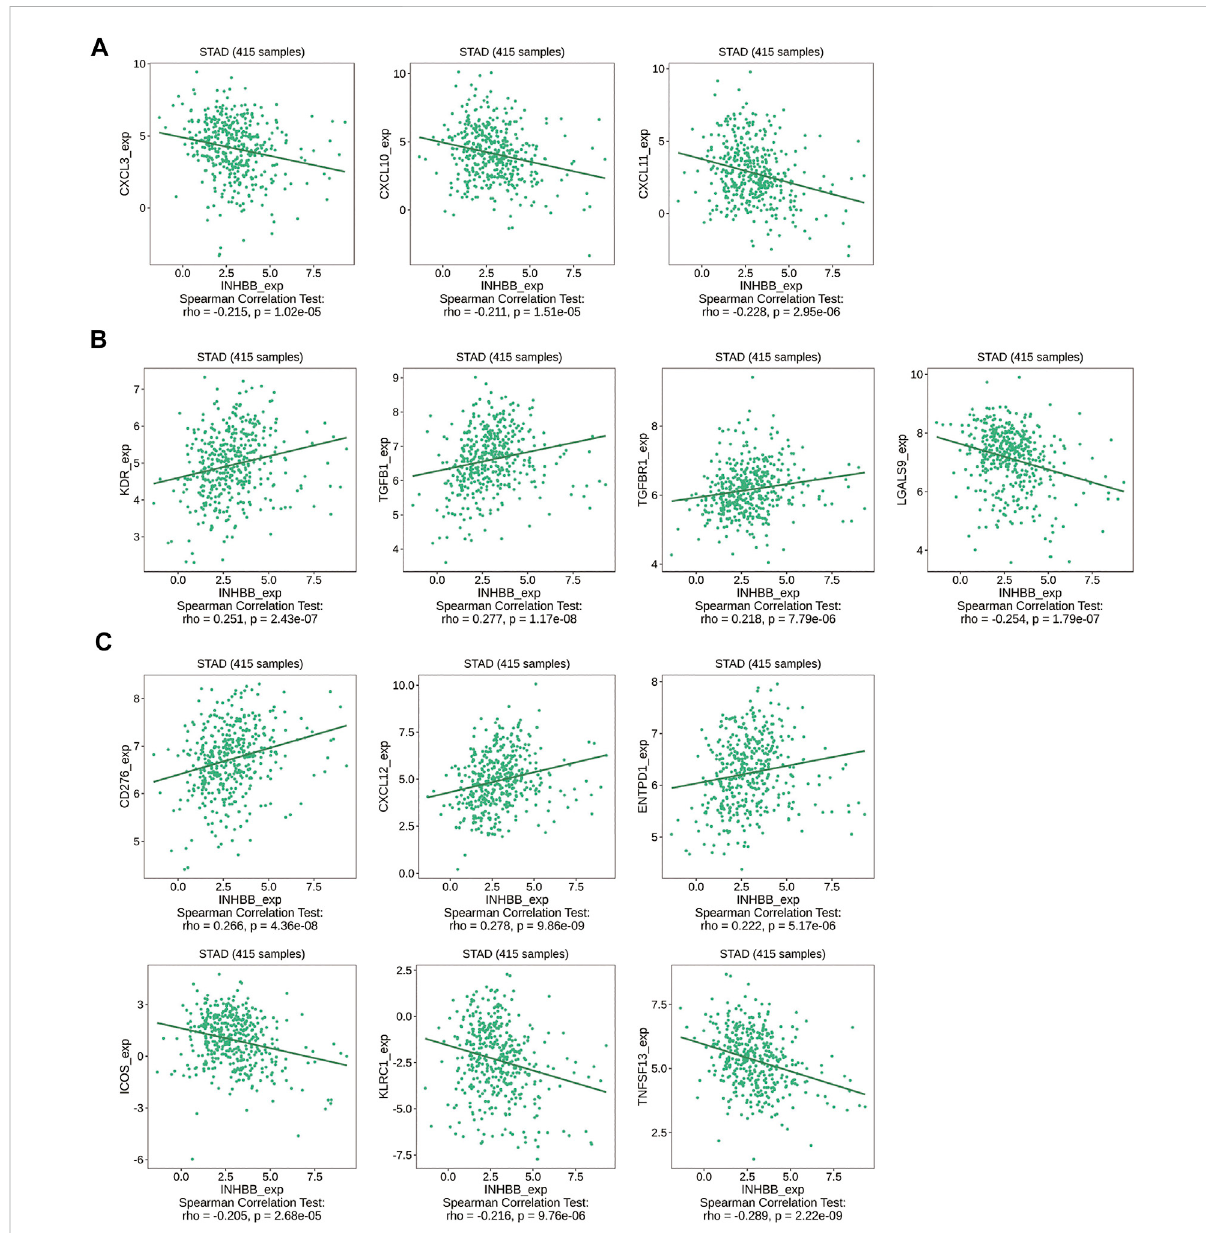
FIGURE 8 Correlation of INHBB expression and (A) chemokines/chemokine receptors, (B) immunoinhibitors, (C)